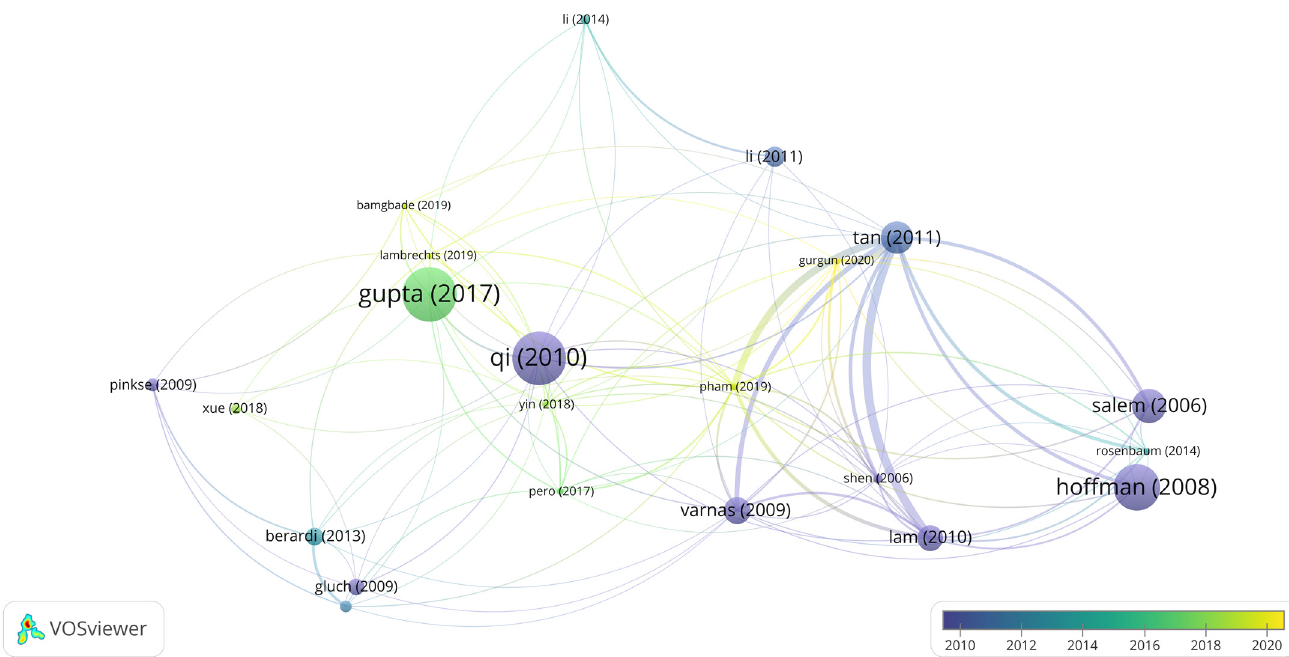
Figure 7. Map of the influential publications and co-citation by cluster.